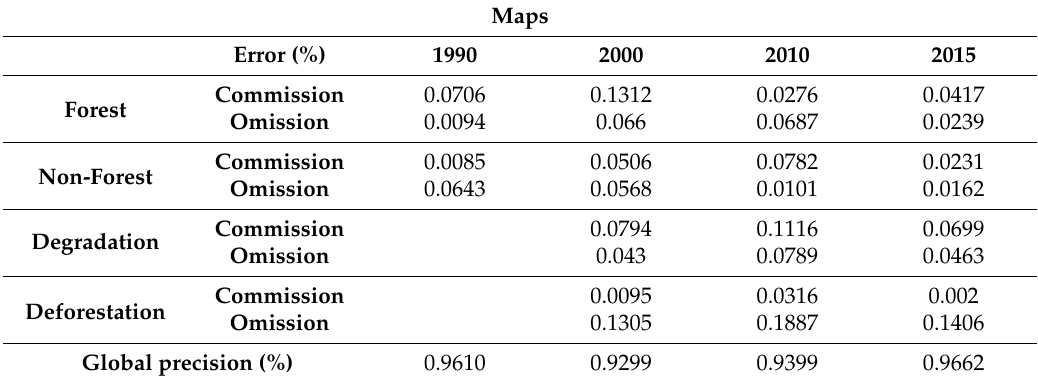
Table 2. Reliability indices of deforestation and forest degradation in terms of estimated proportions of area.